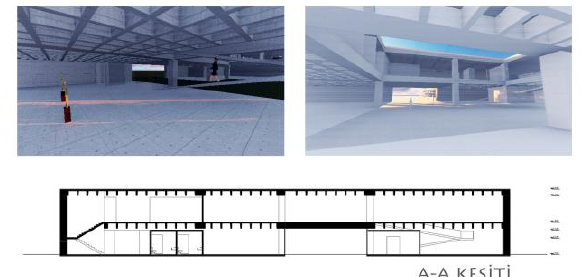
Figure 4: Sample BIM integration in the design studio of 3 rd semester